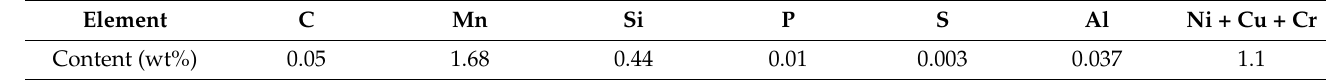
Table 1. Chemical composition of Q420 steel.